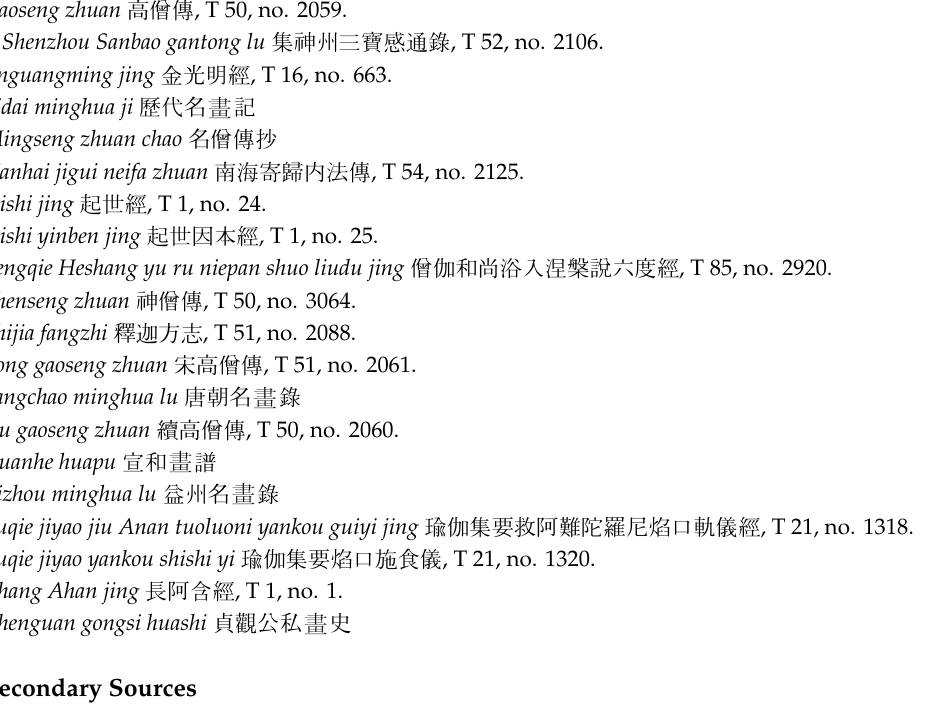
Figure 7. Itinerant Monk . Dunhuang, 10th century. Ink and colors on paper, 51.8 × 29. 3 cm. Inv. No.